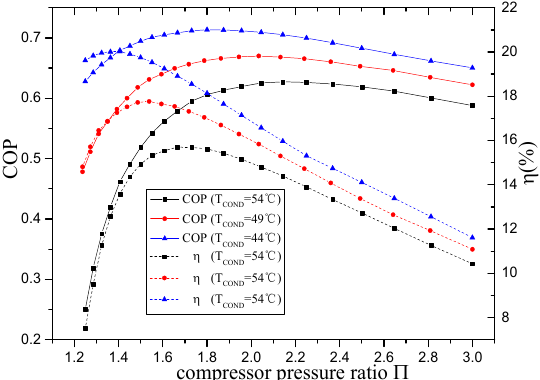
Figure 20. COP and η of configuration 1 versus (cid:2024) at different T COND .